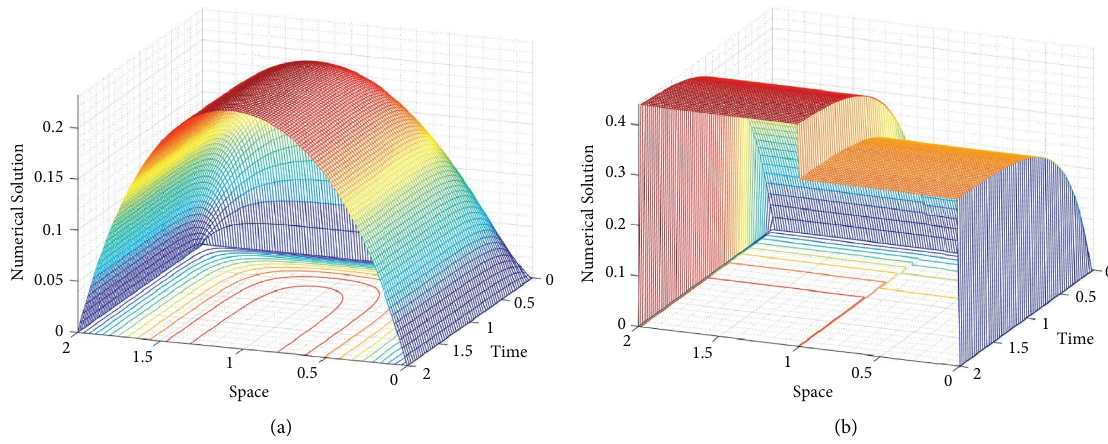
Figure 6: Surface plots for the numerical solution of Example 3 for N � 128 and M � 64. (a) [ ε � 2 0 ], (b) [ ε � 2 − 14 ].